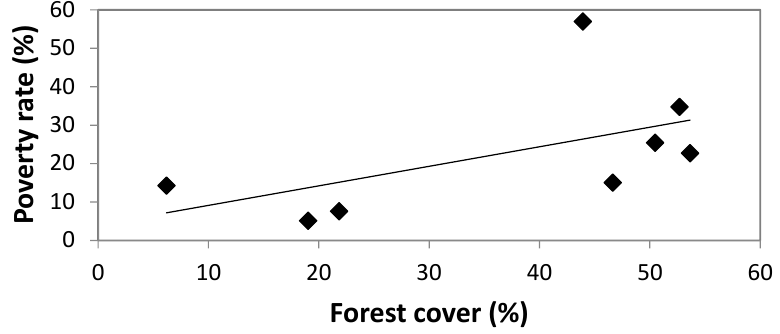
Figure 4. Relationship between forest cover rate and poverty rate in Vietnam. Source: GSO data from 2016 [13].